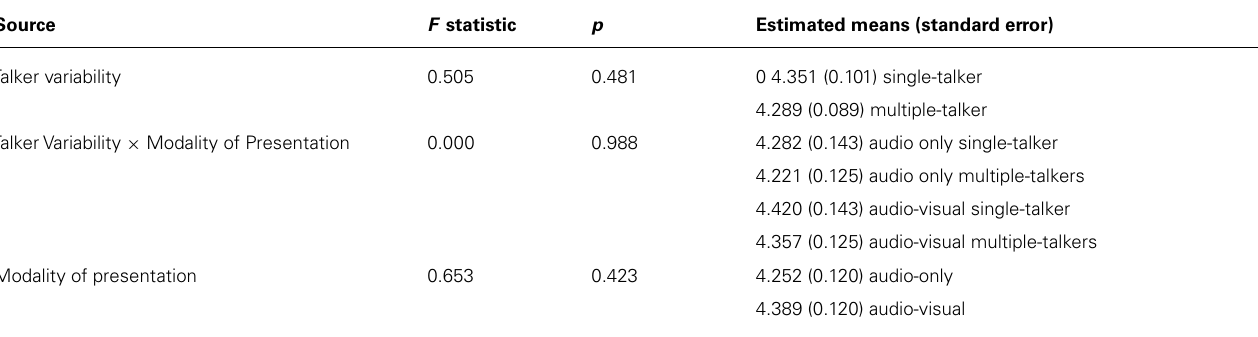
Table 3 | Summary of results from the split plotANOVA [TalkerVariability (Single-Talker vs. Multiple-Talkers) × Modality of Presentation (Audio-only vs.Audio-visual), withTalkerVariability as a within-subject factor and Modality of Presentation as a between-subject factor] for the dependent measure of